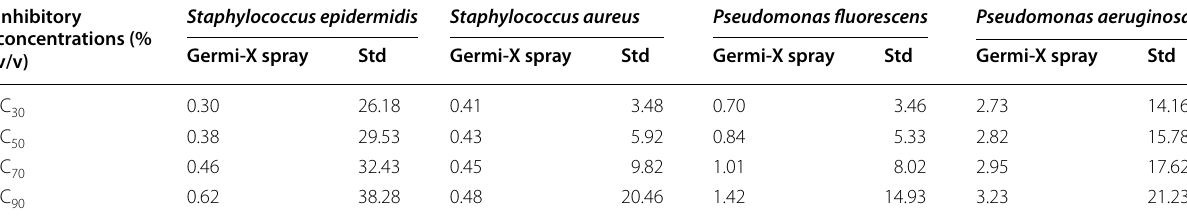
Table 2 IC values of Germi-X spray and standard against different bacterial pathogens 30-90 Inhibitory Staphylococcus epidermidis Staphylococcus aureus Pseudomonas concentrations (% v/v)